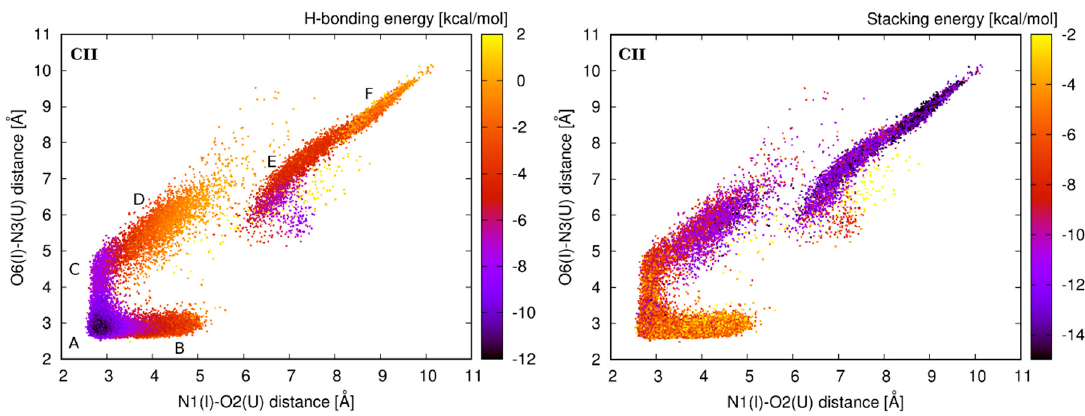
Figure 7. Distribution of the interaction energies in CII system. Left : E H-bond between I 11 and U 30 residues of the first I–U base pair. Right : E stack between the I 11 –U 30 base pair and its 5 ′ base pair neighbor C 10 -G 31 . Color scale represents the interaction energy.